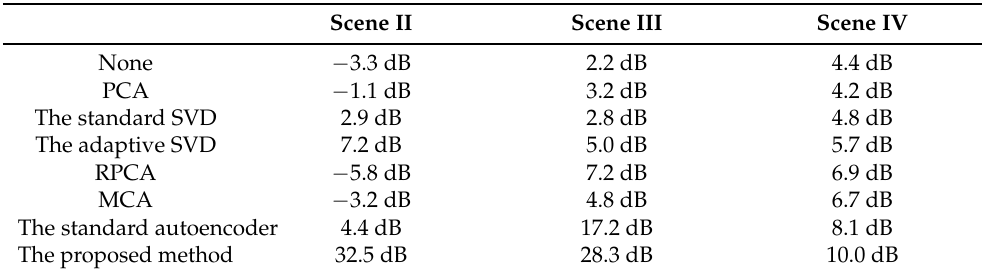
Figure 9. Photograph of measurement setup of Scene IV. ( a ) View of the test scene. ( b ) Hidden target. Table 1. SCR of Different Clutter Mitigation